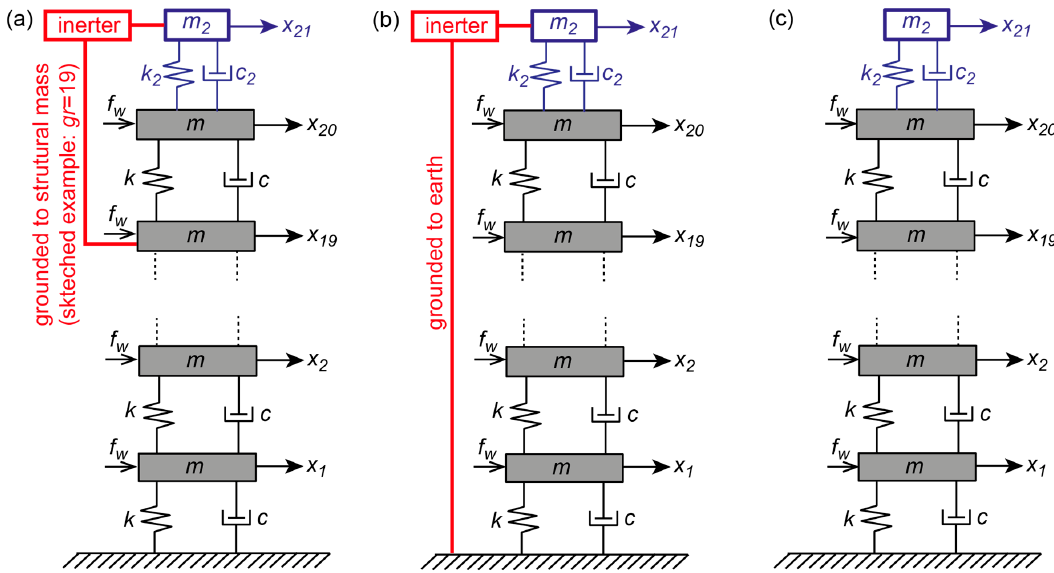
Figure 1. Shear frame structural model with: ( a ) tuned mass damper (TMD) with inerter (TMDI), grounded to one arbitrary structural mass (example: grounded to mass 19); ( b ) TMDI grounded to the earth; ( c ) TMD.